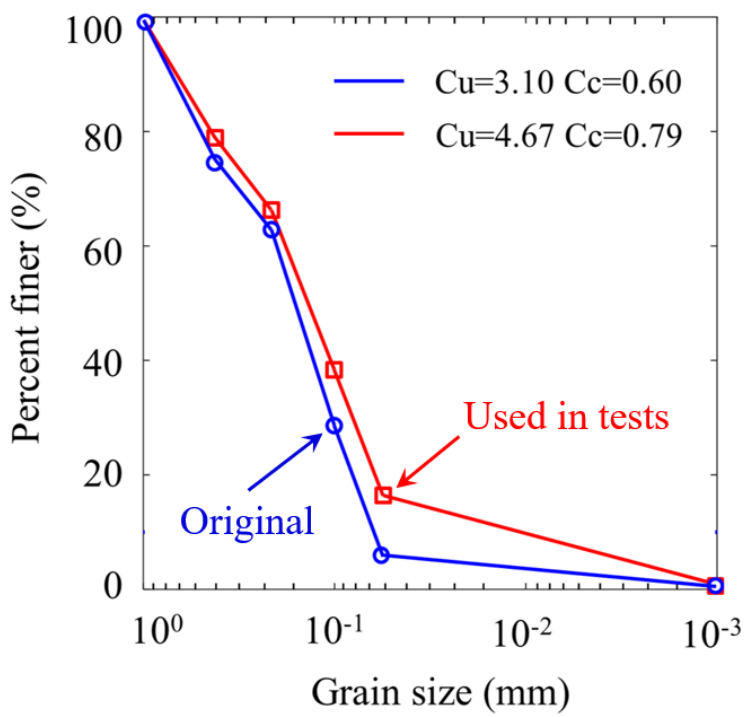
Figure 3. Grain size gradation of the original coral sand and the re-proportioned sand. The arrangement of sensors in the physical model is shown in Figure 4. Eight three- directional acceleration sensors are buried in the coral sand foundation, of which A0 is placed at the bottom of the model box for recording and calibrating the incident seismic waves. Nine pore pressure sensors are installed in the coral sand foundation, layer by layer. Eight displacement sensors (including LVDT and laser displacement meter) are installed to record the horizontal and vertical displacement responding of the breakwater and runway, respectively. In the test, to ensure the density and uniformity of the foundation, the coral sand foundation is prepared by the layered compaction method, and each layer is compacted to only 120% of the predetermined height. Through several tests, it is found that the designed layer thickness can be achieved by leaving 20% extra thickness for each layer of the coral sand after settling in the 50 g centrifugal gravity field. Sensors are installed at designed locations as that in Figure 4. After model preparation, the HPMC solution is poured into the stacked laminar box, and then the physical model is saturated in the 50 g centrifugal gravity field for half an hour. The completed physical model is shown in Figure